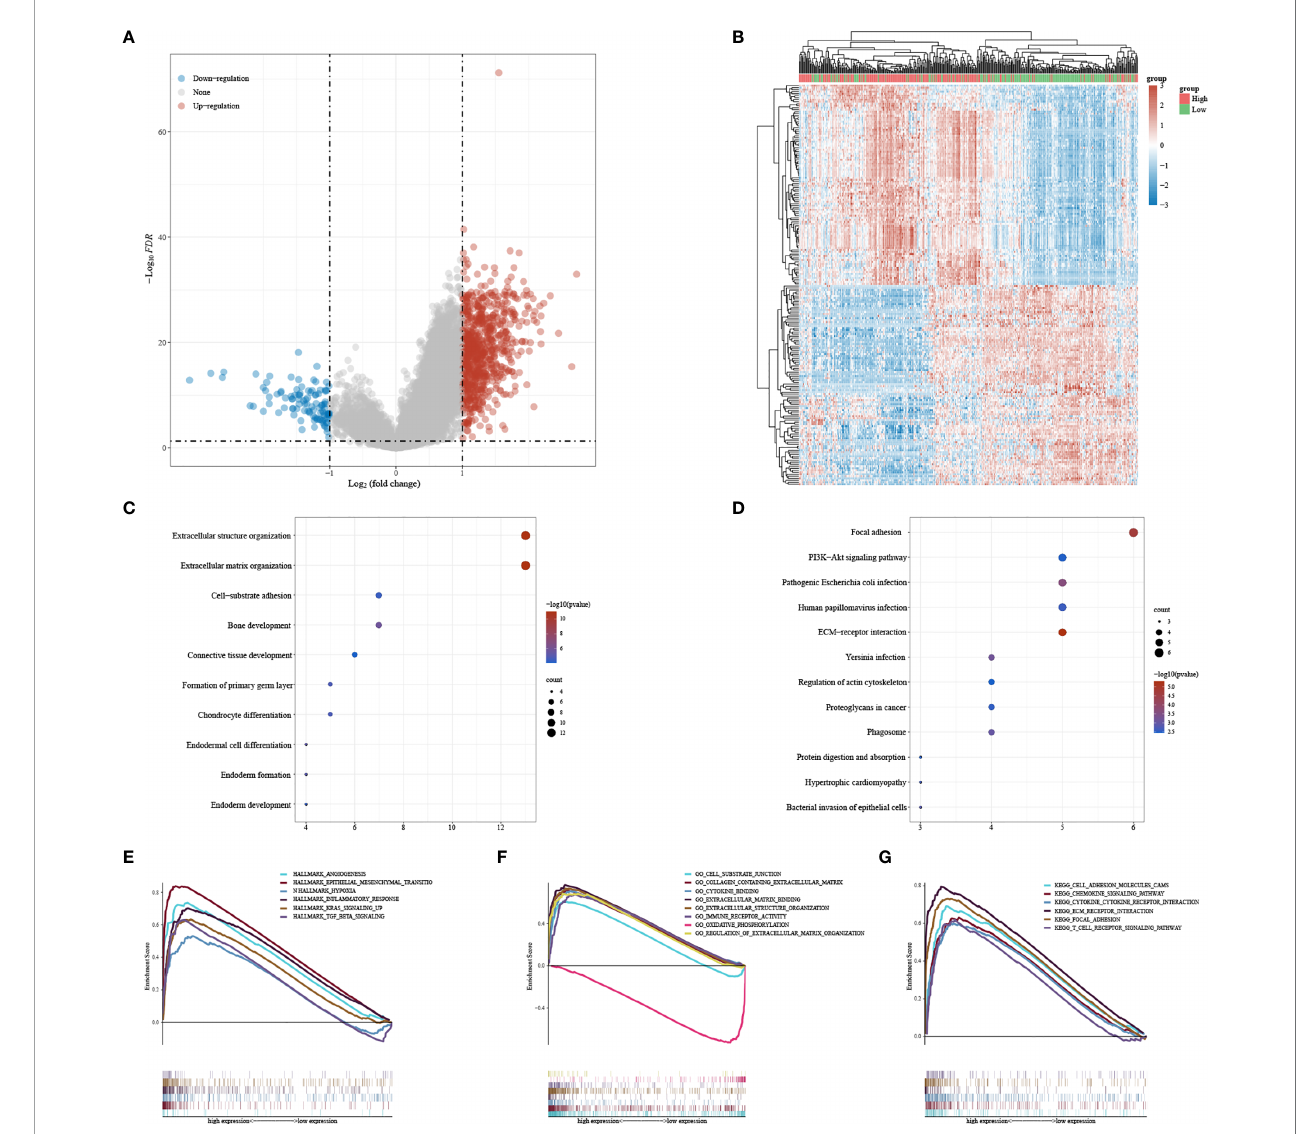
FIGURE 4 | DEGs and functional enrichment analysis between CALU high and CALU low groups. (A, B) the DEGs between CALU high and CALU low groups were shown in the heatmap and volcano plot. (C, D) GO and KEGG enrichment analysis con fi rmed that patients with higher CALU expression owned higher extracellular matrix remodeling activities (E – G) The GSEA suggested that the CALU high expression group had higher EMT, hypoxia, cytokine receptor and T cell receptor